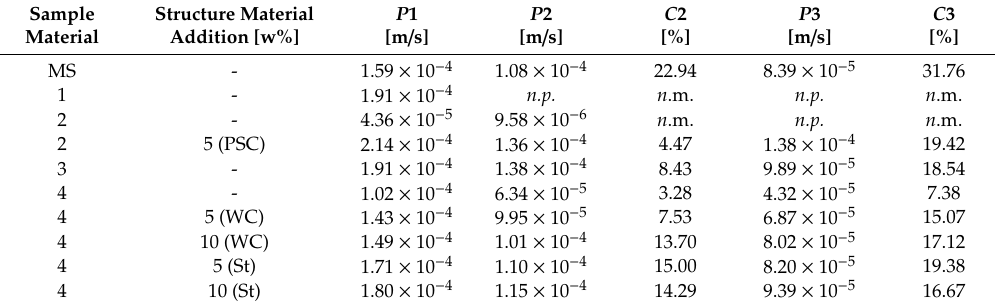
Table 3. Permeability of chicken manure with and without structure material